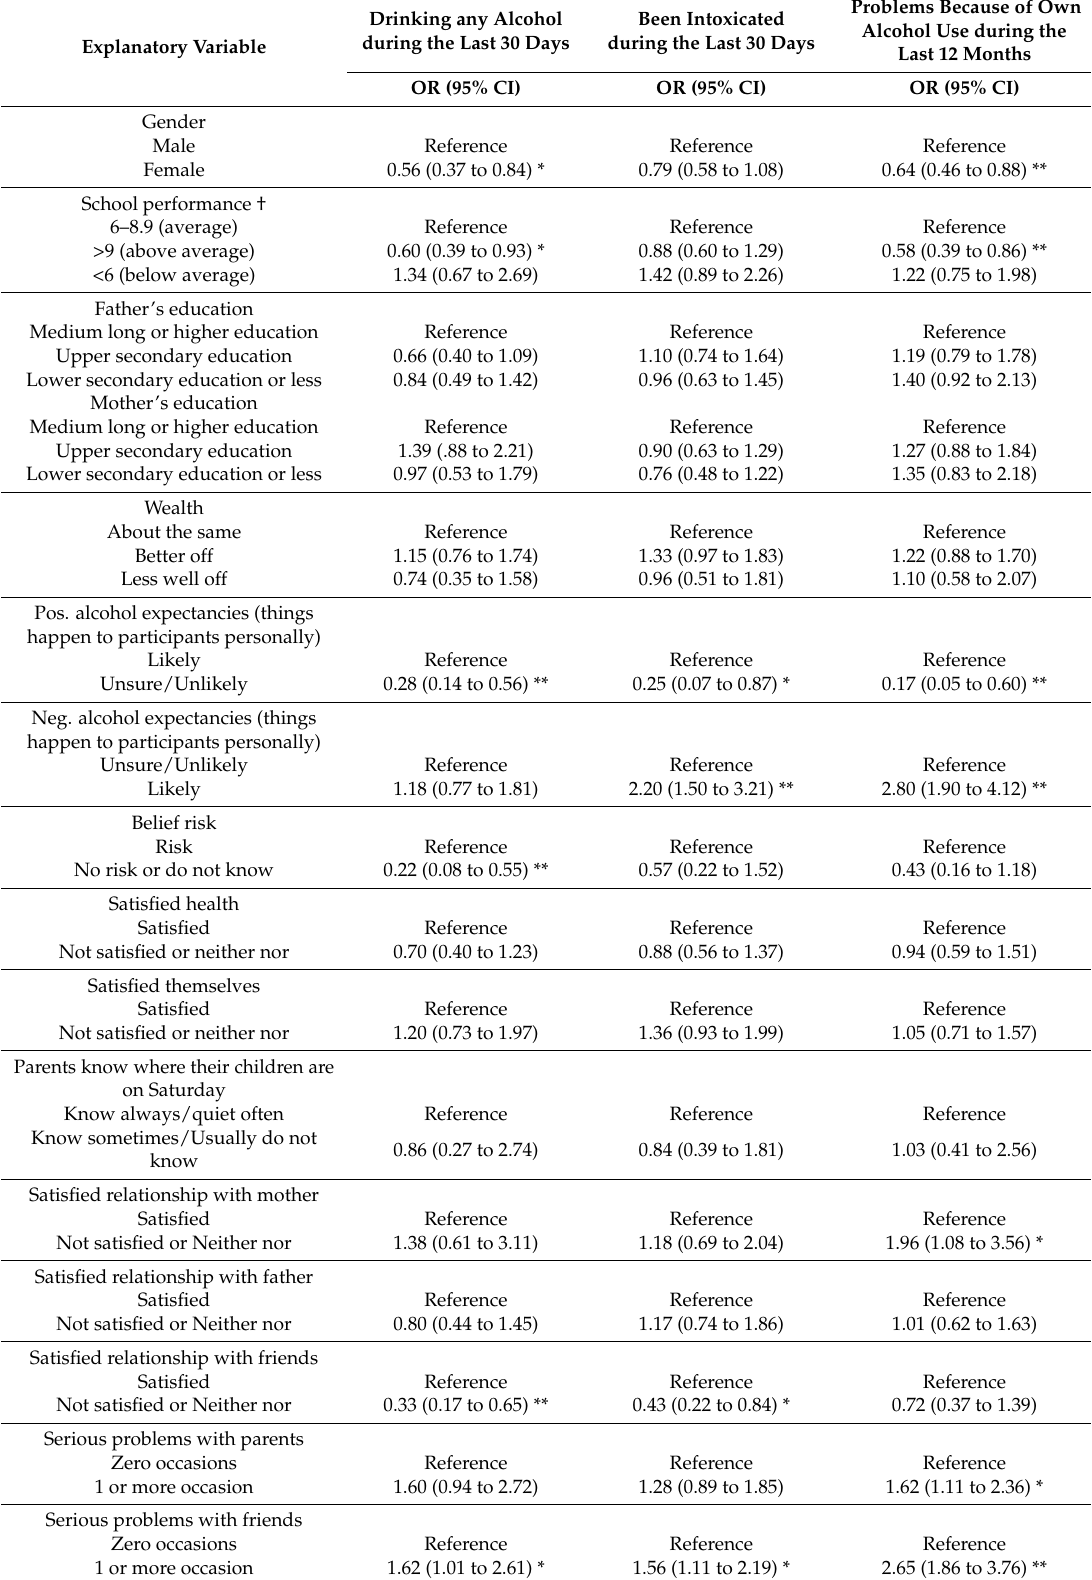
Table 2. Multivariable